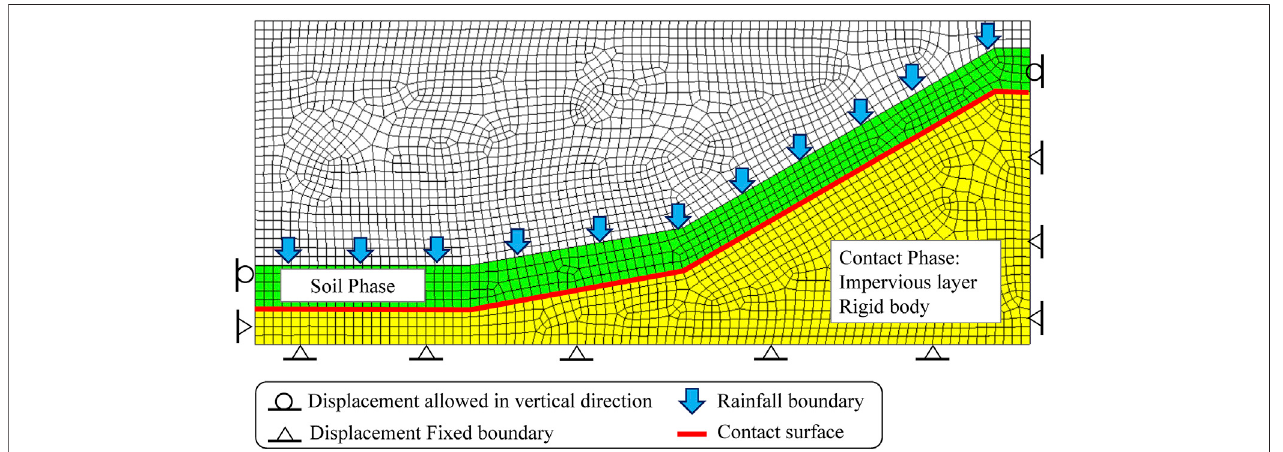
FIGURE 5 | Con fi guration in the simulation of a rainfall-induced slope failure.